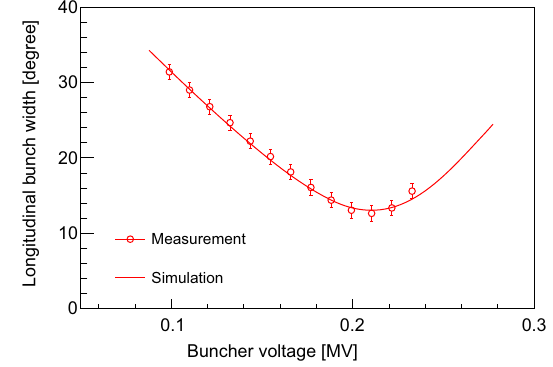
FIG. 16. Bunch-width dependence on scanning the buncher voltage. The red-solid line indicates the fitting using the IMPACT simulation.